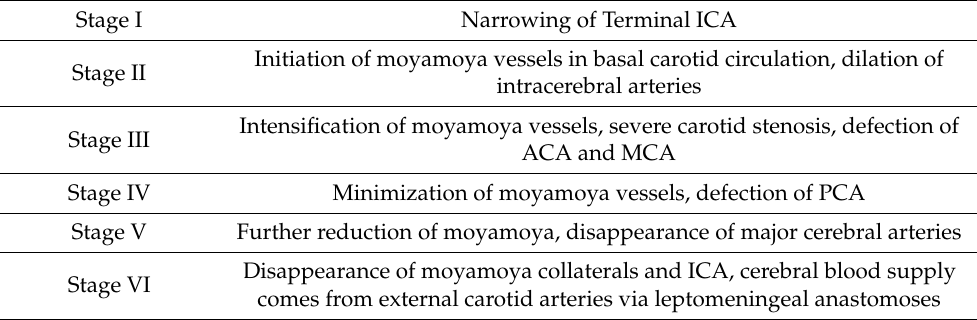
Table 1. Suzuki grading system [adapted from 47].